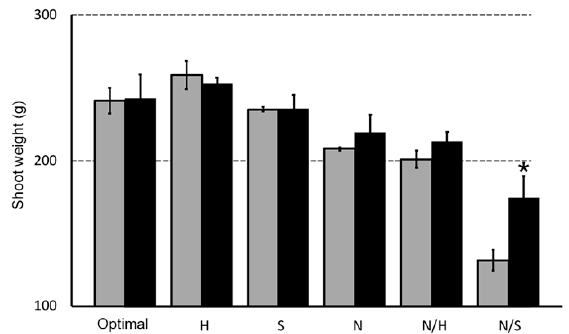
Figure 3. Effects of APR® on root weight in response to different single and combined abiotic stresses. Maize seedlings were subjected for 3 days to several abiotic stresses in absence (grey bars) or in presence (black bars) of 5% APR®. The applied single stresses were: hypoxic stress (H), salt stress (S), nutritional stress (N). The single stresses were combined as: hypoxic stress plus nutritional stress (N/H) and salt stress plus nutritional stress (N/S). The values of root weight (g) are represented in the graphs (mean ± SE) and were calculated from three independent experiments ( n = 10). Significantly different values are evidenced by * (*: p < 0.05; **: p < 0.02; One-way ANOVA, Tukey’s HSD test).